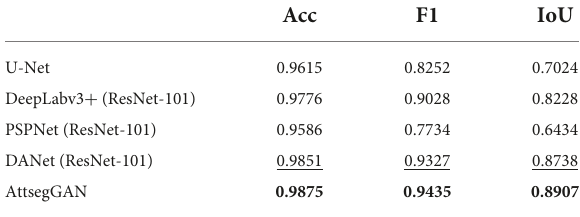
TABLE 3 Statistics of comparative experiment results on WHU building dataset.